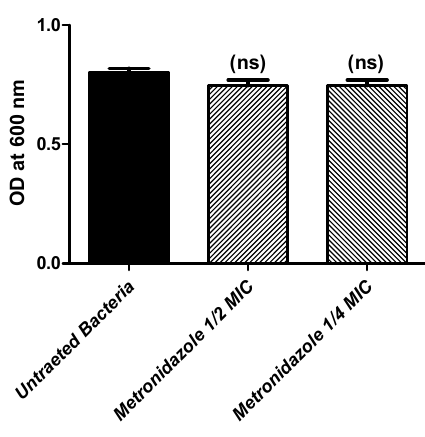
Figure 1. Effect of metronidazole in sub-MIC on P. mirabilis growth. LB broth with or without metronidazole (½ MIC or ¼ MIC) was inoculated with a fresh inoculum of adjusted P. mirabilis to 0.5 McFarland Standard equivalent and the optical densities were measured after overnight culturing at 37 °C. One-Way ANOVA test was applied to compare between bacterial growth in presence and absence of metronidazole; statistical significance was assumed when p values < 0.05. There was no statistical significance between metronidazole treated and untreated cultures ( p > 0.05).